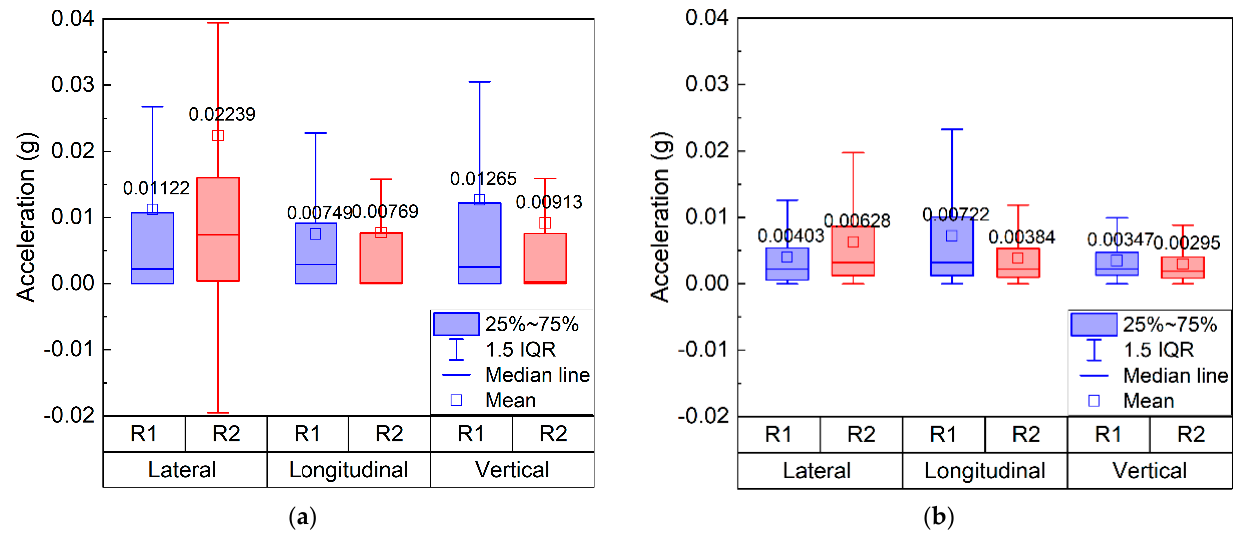
Figure 18. The box plots showing statistical distributions of 3D acceleration recorded by #R1 and #R2 at the same depth of the ballast bed ( a ) prior to and ( b ) after maintenance operations.